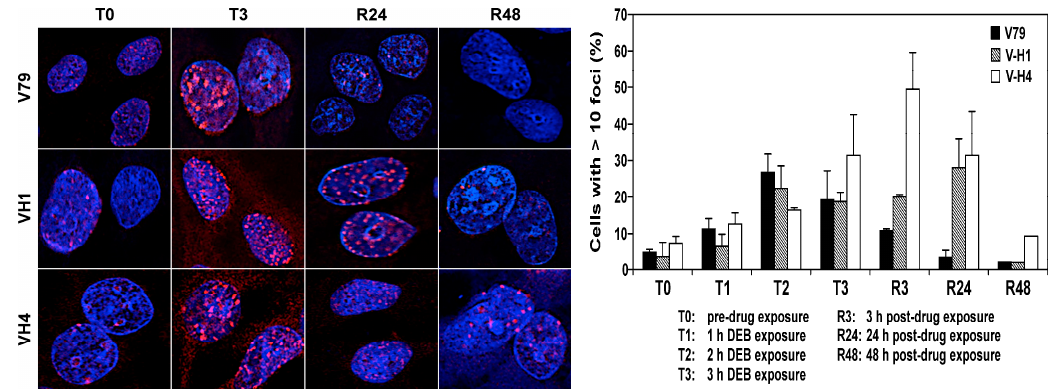
Figure 6. Images ( left ) and dynamics ( right ) of phosphorylated histone H2AX-containing foci in V79, V-H1 and V-H4 cells prior to and following exposure to 15 µM DEB. Cells were exposed to 15 µM DEB for 3 h and subsequently DEB was removed and replaced with fresh growth media. At the indicated times, immunocytochemistry was performed using a rabbit polyclonal antibody specific for phospho-H2AX, as described in the Methods section. Time points are the same as Figure 3. The data represent the percentage of cells within randomly selected microscope fields that contained 10 or more foci, plus the standard error of the mean, n = 3. * p < 0.05.